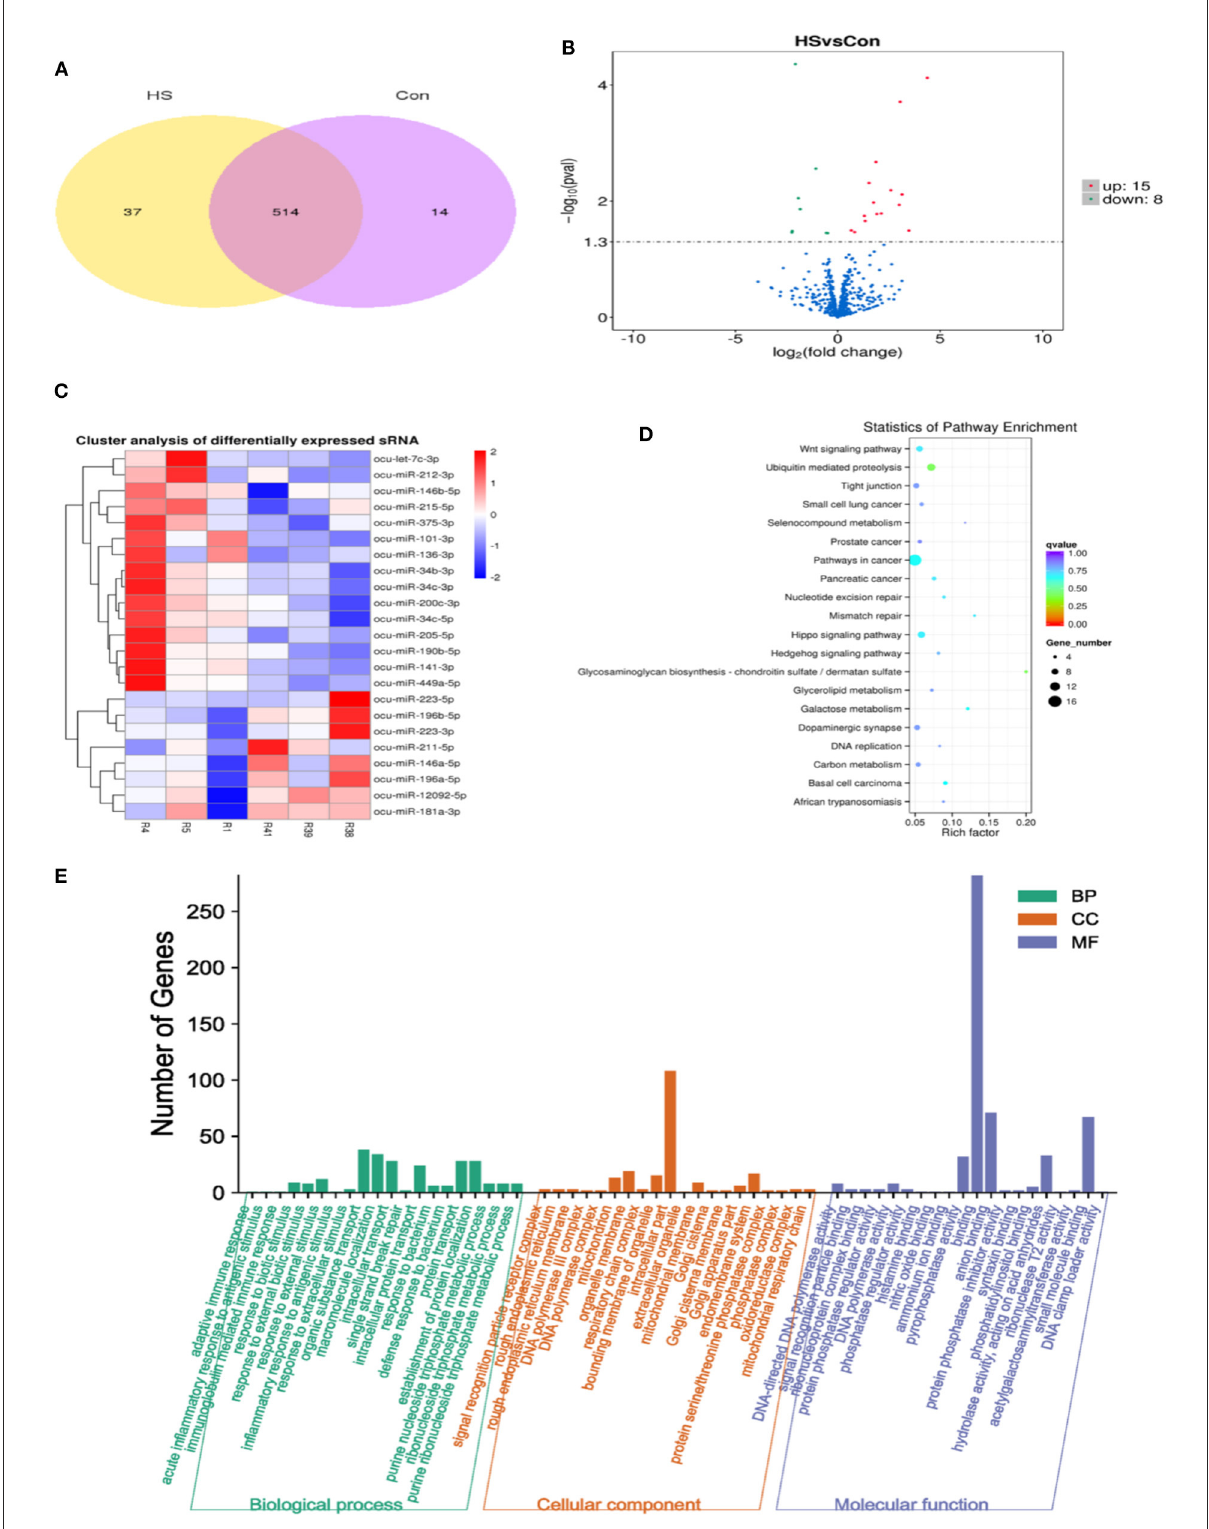
FIGURE4 Analysis of DE miRNAs from rabbit ovary in CON group and HS group. (A) Venn diagram illustrating common and different DE miRNAs between HS and CON; (B) Analysis of DE miRNAs by volcano map; (C) Hierarchical cluster diagram of DE miRNAs; (D) KEGG pathway enrichment analysis of target genes in DE miRNAs; (E) GO enrichment analysis of target genes in DE